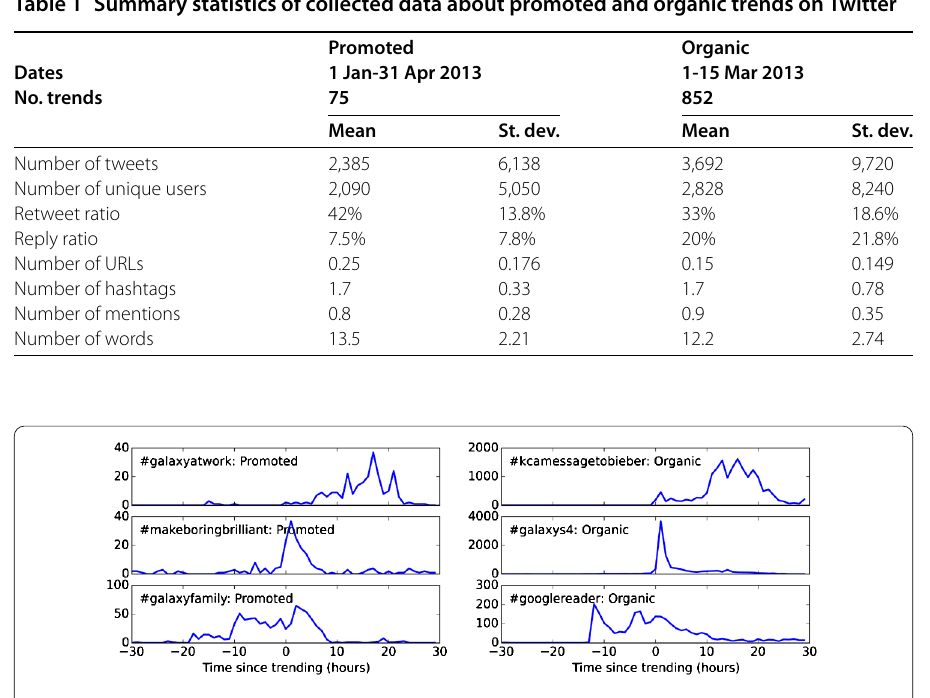
Figure 1 Time series of trending hashtags. Comparison of the time series of the volume (number of tweets per hour in our sample) relative to promoted (left) and organic (right) trends with similar temporal